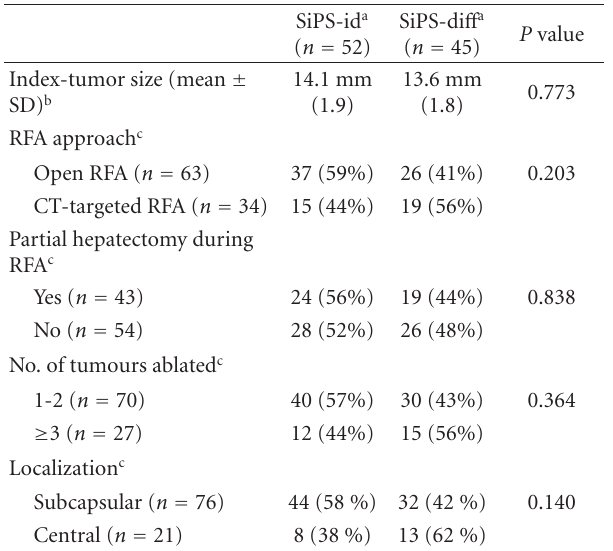
Table 2: E ff ect of di ff erent factors on the Similarity of Positioning Score (SiPS).